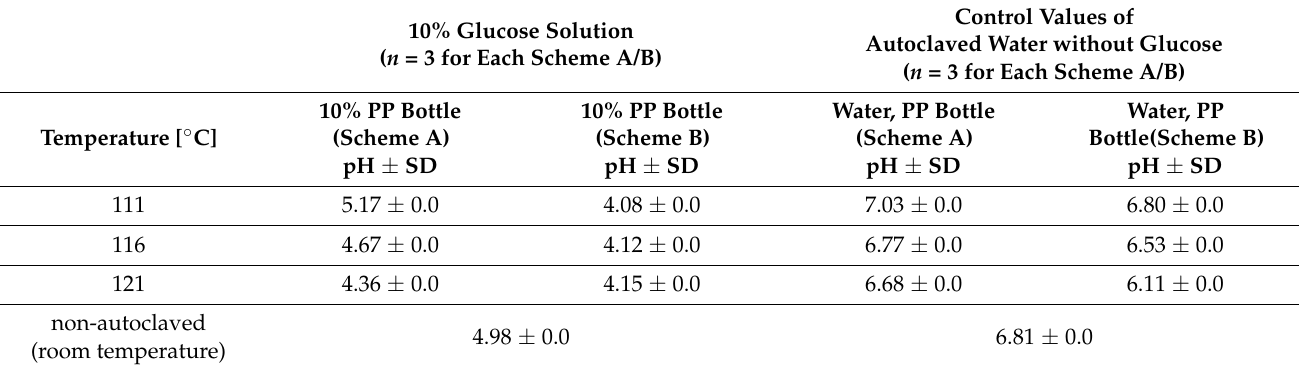
Table 3. Overview of the obtained pH-values ± SD (= standard deviation) in different temperatures/sterilization- times/vessels. 10% Glucose Solution ( n = 3 for Each Scheme A/B)